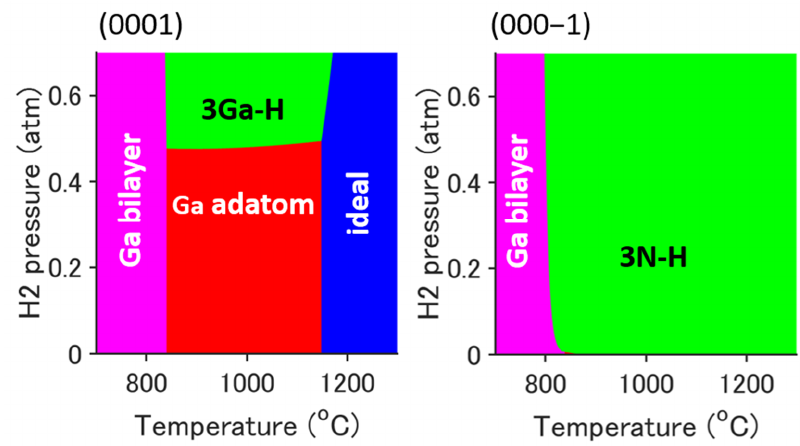
Figure 1. Surface phase diagram of GaN(0001) and (000 − 1) during the MOVPE growth process. The growth conditions are p Ga = 2.5 × 10 − 4 atm and p carrier = p N2 + p H2 = 0.7